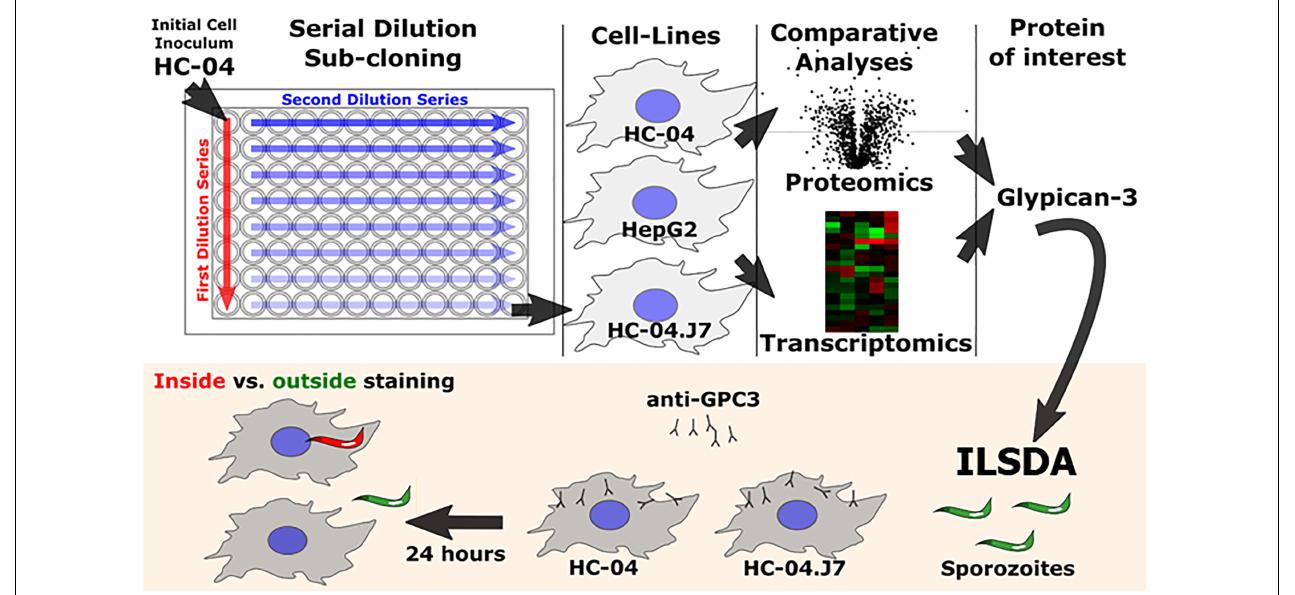
FIGURE 1 | Schematic of the overall experimental approach utilized in this study. ILSDA, inhibition of liver stage development assay.